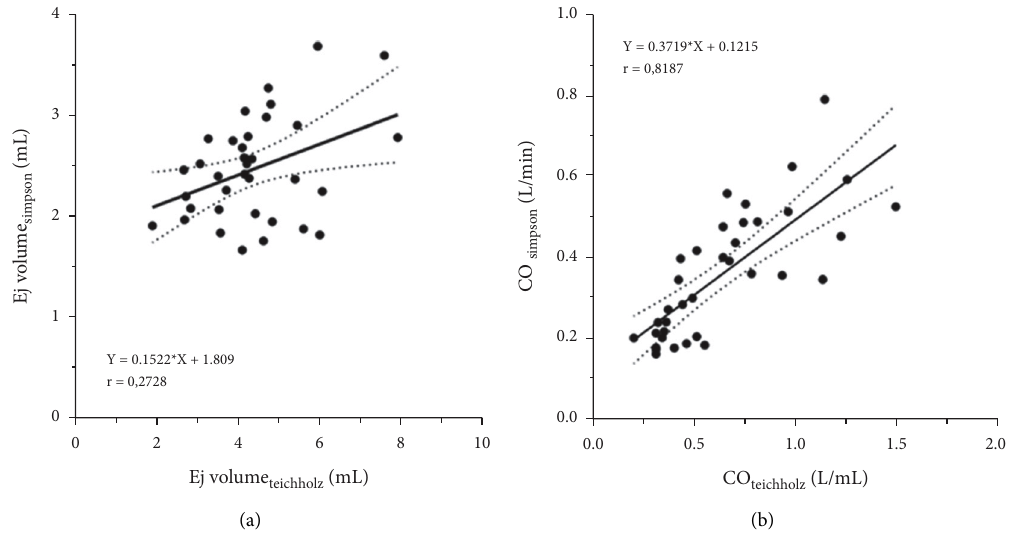
Figure 8: (a) Spearman correlation between the ejected volume obtained by the Teichholz and Simpson methods. Te correlation obtained had r � 0.27 of 18 measurements. (b) Spearman correlation between cardiac output (CO) obtained by the methods of Teichholz and Simpson. Te correlation obtained had r � 0.82 out of 18